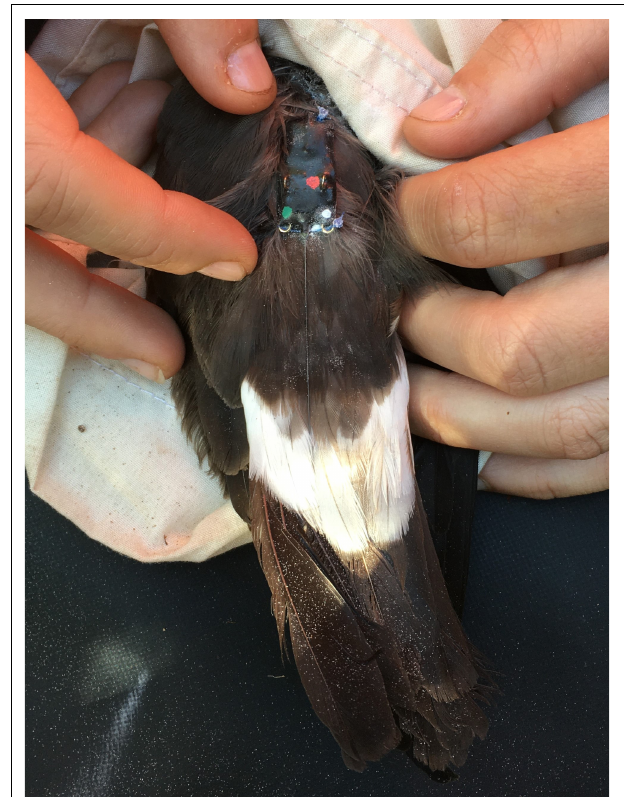
FIGURE 1 | Adult Leach’s Storm-Petrel with a GPS sutured to its back (photo taken by Sydney M.